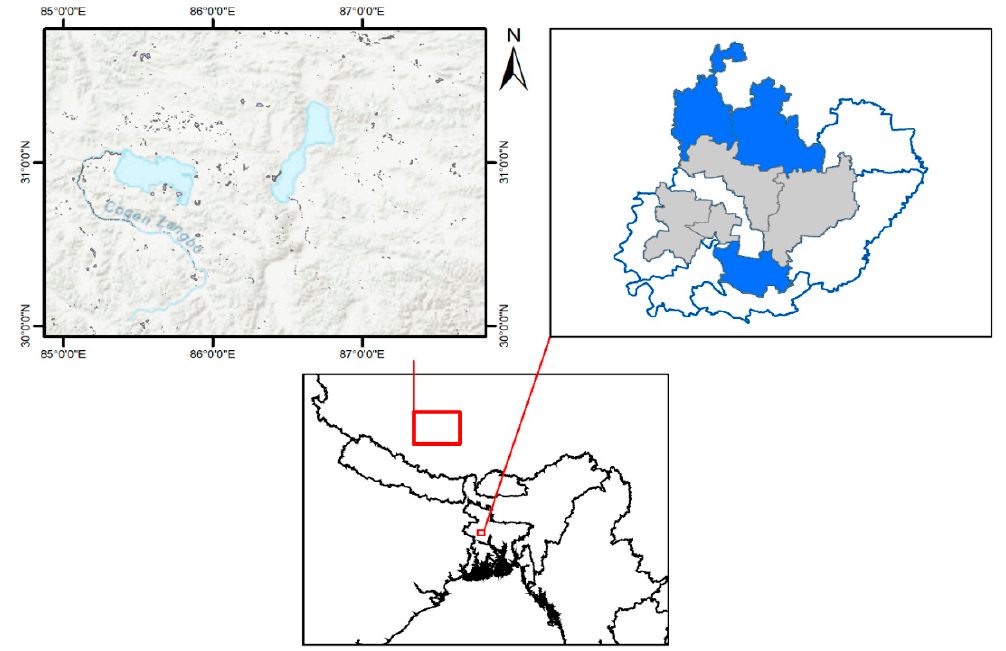
Figure 4. Locations of region used to select training and test samples. Upper left: the region on Tibetan Plateau for selecting negative samples. Upper right: blue unions are for training positive samples; grey unions are for testing samples.